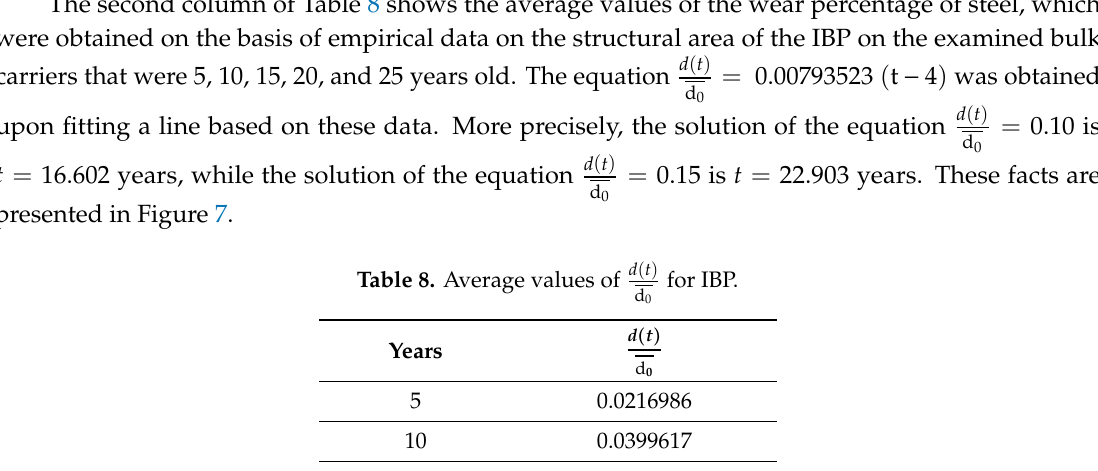
for IBP. (cid:2914) (cid:3116)